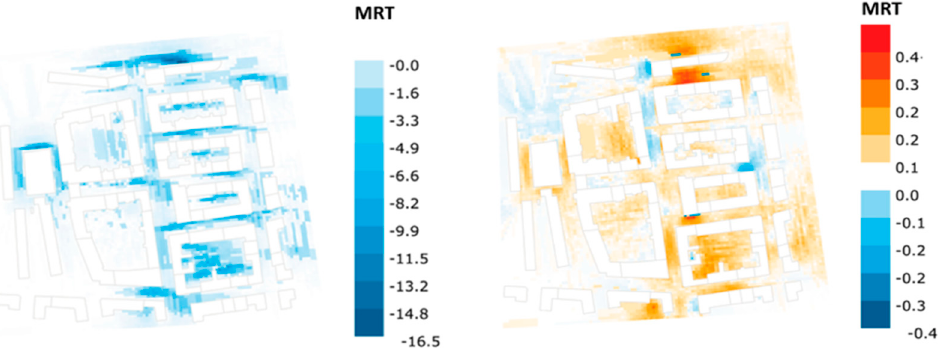
Figure 9. Twelve-hour MRT differences at street level between base case and densification scenario for smaller sample area for daytime ( left ) and nighttime ( right ).